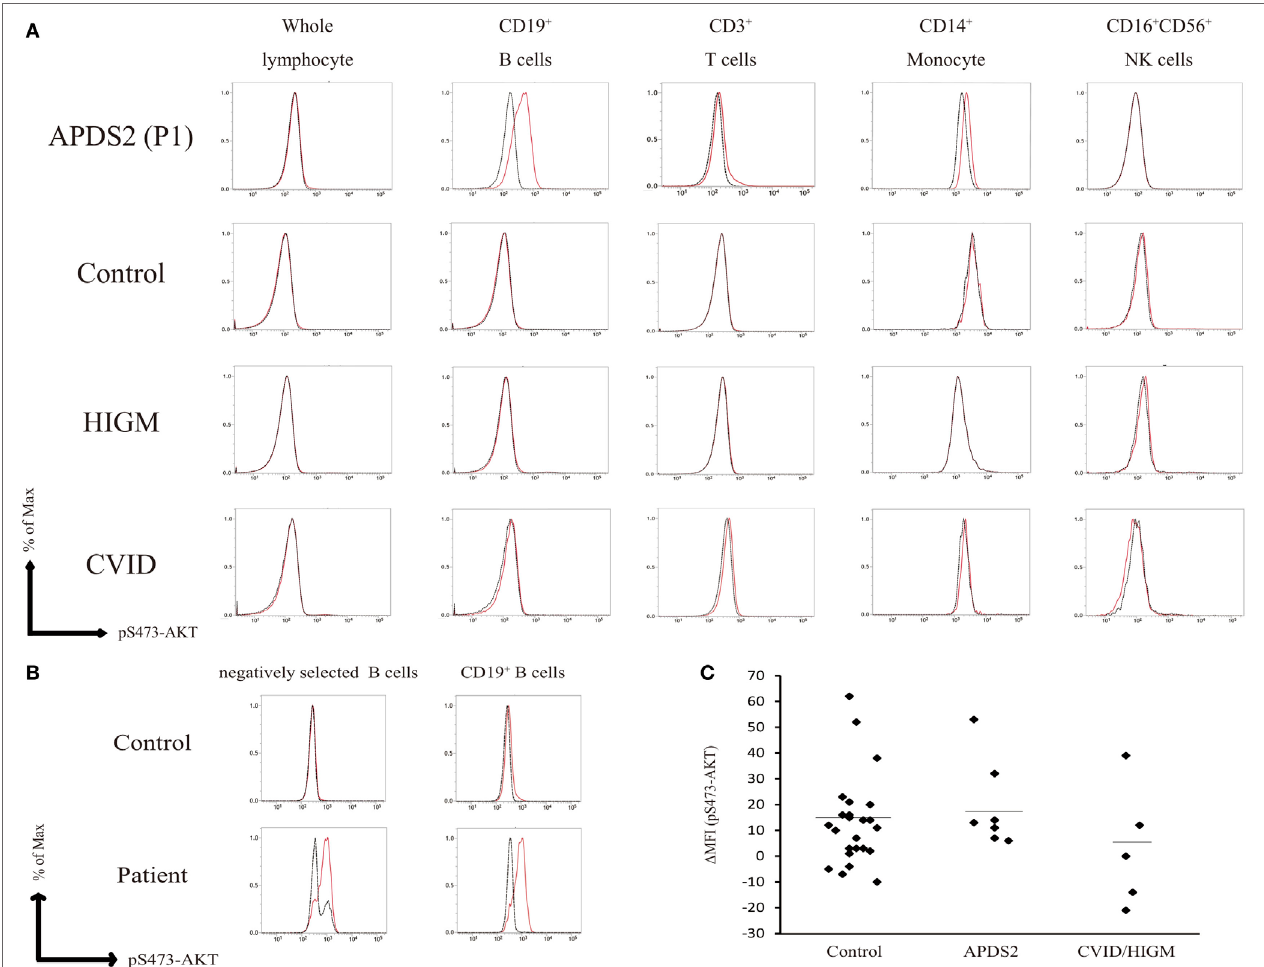
FigUre 2 | Flow-cytometry-based AKT phosphorylation (pAKT) assay of PMBCs. (a) The level of pAKT in the presence or absence of p110 δ inhibitor treatment was assessed by flow cytometry in total peripheral blood mononuclear cells (PBMCs), CD3 + T cells, CD14 + monocytes, and CD16 + CD56 + natural killer cells from activated PI3K δ syndrome 2 (APDS2) (P1), common variable immunodeficiency (CVID) (P8), or hyper IgM syndrome (HIGM) (P9). The number of events analyzed was > 5,000. Red bold line: no treatment and black dotted line: p110 δ inhibitor treatment. (B) The level of pAKT in negatively selected B cells from PBMCs from P1 and one healthy control was compared with pAKT in CD19 + B cells. Red solid line: no treatment and black dotted line: p110 δ inhibitor treatment. (c) A summary of difference in mean fluorescence intensity of whole lymphocytes derived from 24 adult healthy controls or all of the patients with APDS2 or CVID/HIGM. There is no statistical significant among this three groups (control vs. CVID; p = 0.24, APDS2 vs. CVID; p = 0.13, and control vs. APDS2; p =